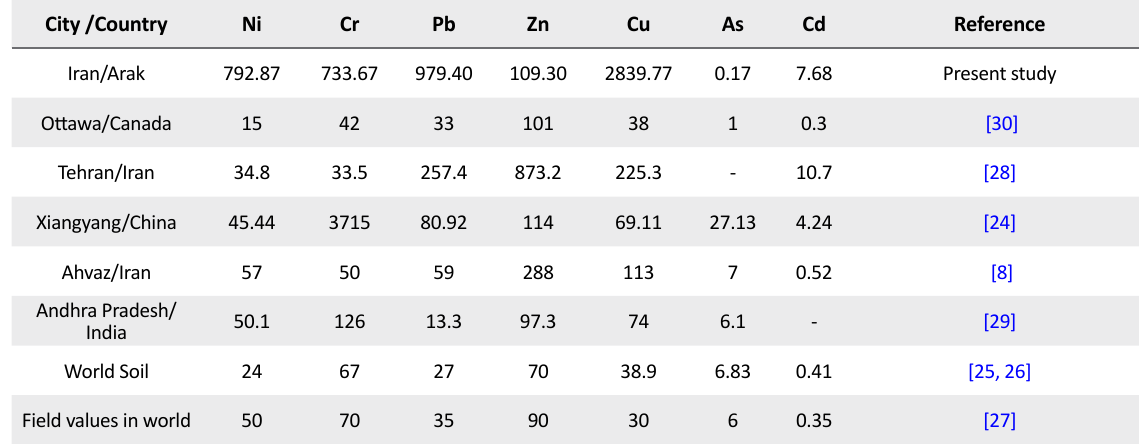
Table 6. Average concentration of toxic elements (mg/kg) in Arak and other cities of the world ReferenceCdAsCuZnPbCrNiCity /Country